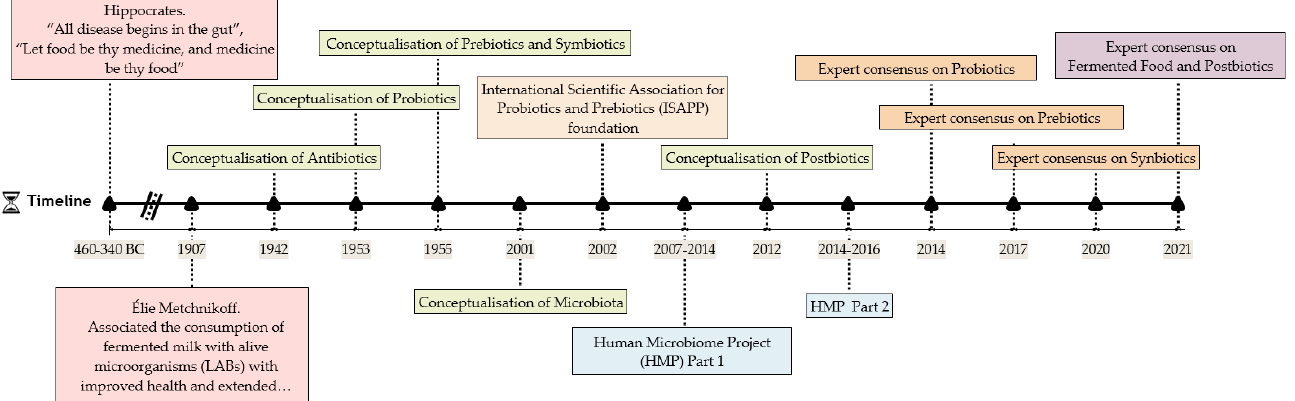
Figure 1. Timeline illustrating the main historical milestones in microbiology, the biotics family and health.